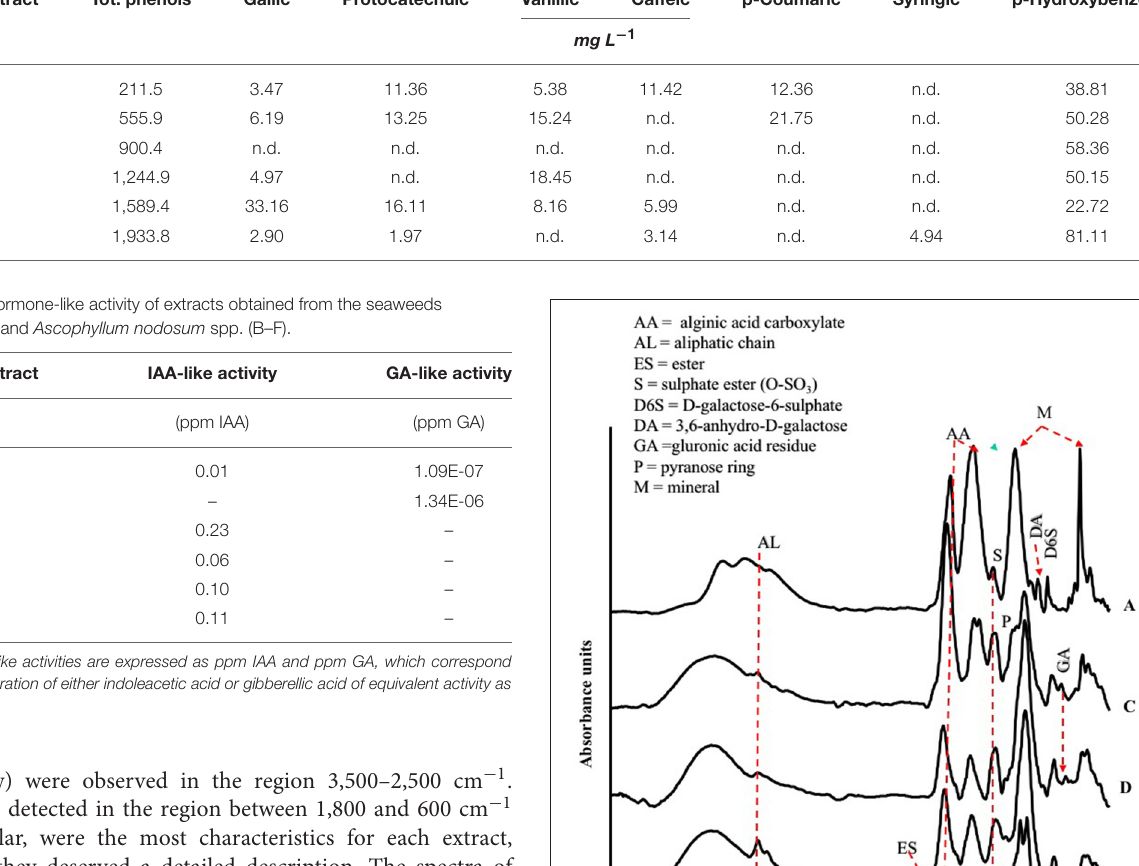
TABLE 2 | Content of total phenols and individual phenolic acids in extracts obtained from the seaweeds Laminaria (A) and Ascophyllum nodosum spp. (B–F). Seaweed extract Tot. phenols Gallic Protocatechuic Caffeic